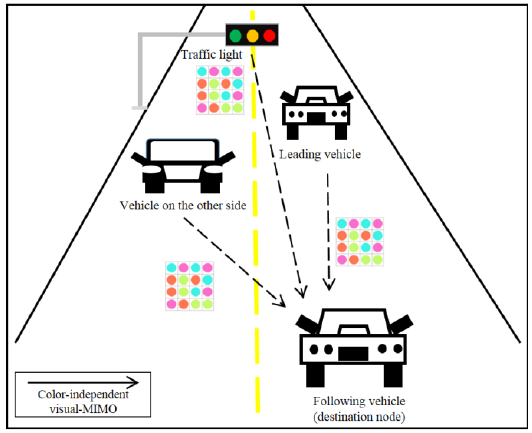
Figure 5. Multi-node V2X communication.